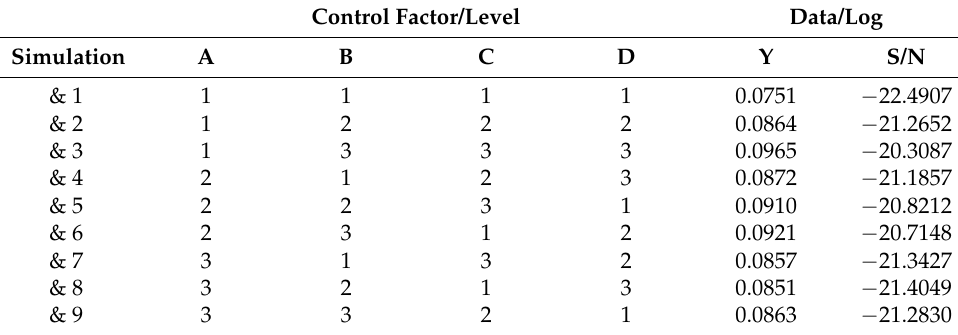
Table 7. Convex ANSYS simulation